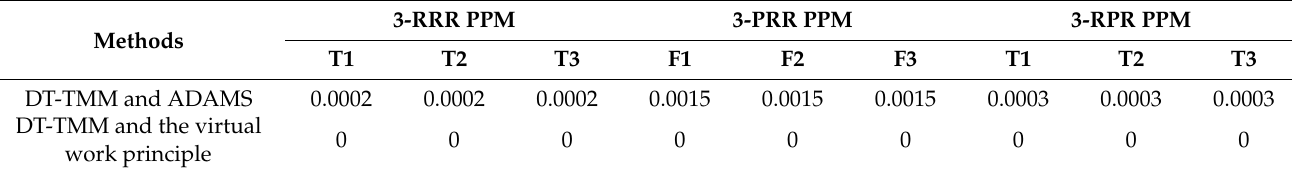
Table 2. The root mean square error between the different methods of three